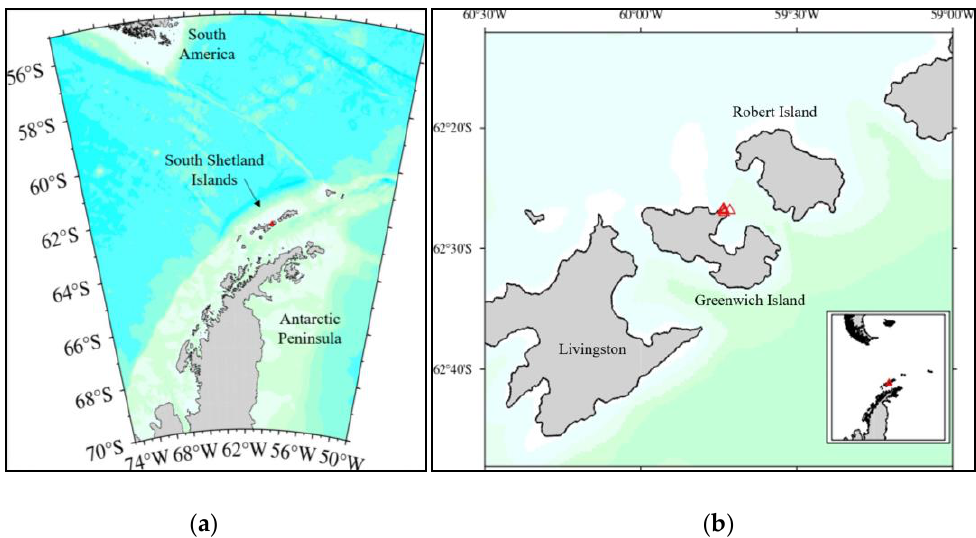
Figure 1. Map of the study area. ( a ) Location of the South Shetland Islands in relation to South America and the Antarctic Peninsula, ( b ) Greenwich Island within the South Shetland Islands which includes the sampling location ( ∆ ).